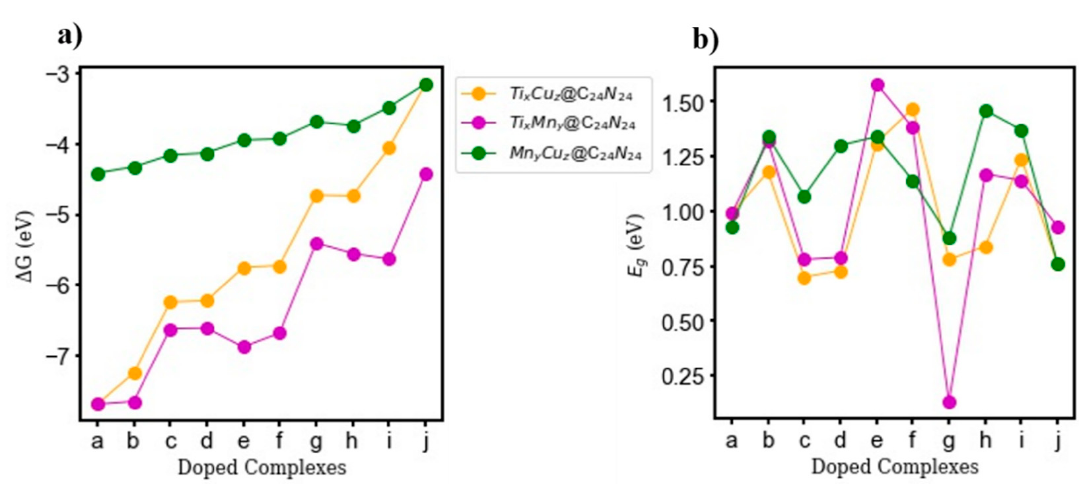
Figure 5. ( a ) The calculated changes in free energy ( ∆ G, at 298 K and 1 atm) ( b ) and energy gap for Ti x Cu z @C 24 N 24 , Ti x Mn y @C 24 N 24 , and Mn y Cu z @C 24 N 24 (x, y, z = 0–6). a–j refer to the bi-metal configurations with different metal ratios listed in Table 1.